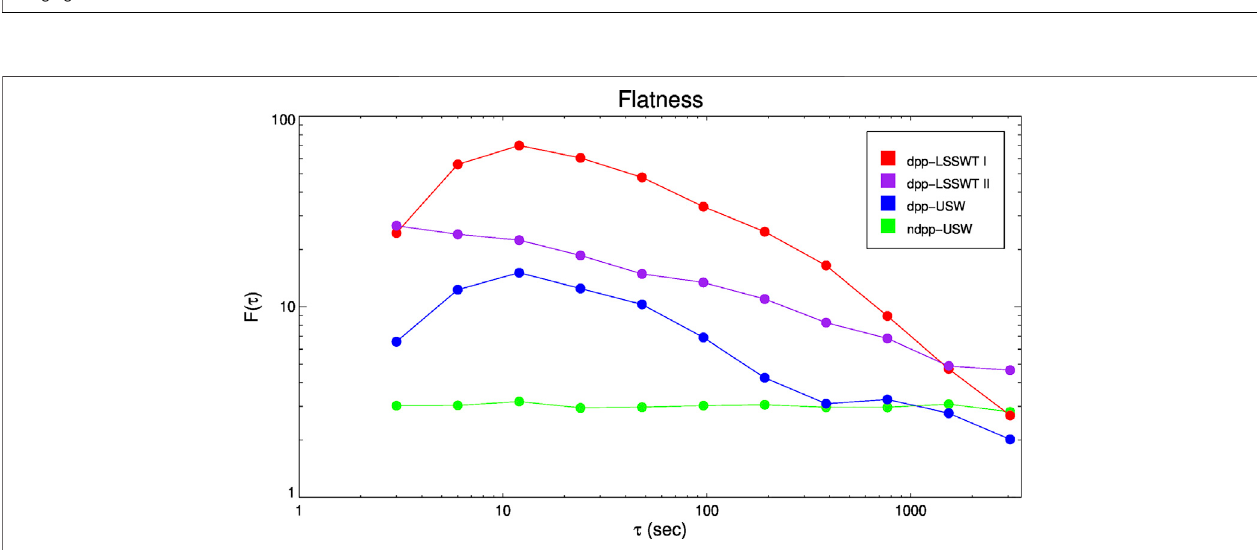
FIGURE 6 | Flatness factor F as a function of different time lags ranging from 3 to 3,072 s, relative to fl uctuations of the plasma density observed in ndpp-USW region (green), dpp-USW region (blue), dpp-LSSWT I region (red), and dpp-LSSWT II region (pruple), respectively). The time intervals of four distinct regions are presented in Figure 4